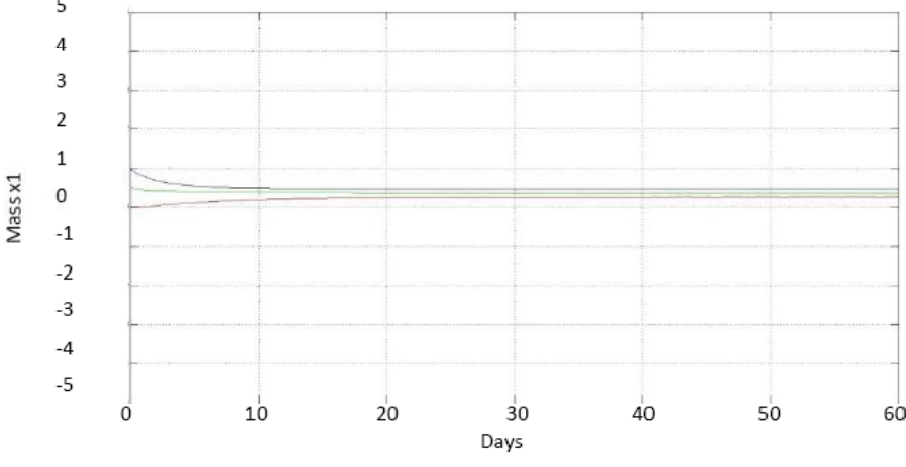
Figure 3. Estimation of the concentration of anaerobic mass x1.